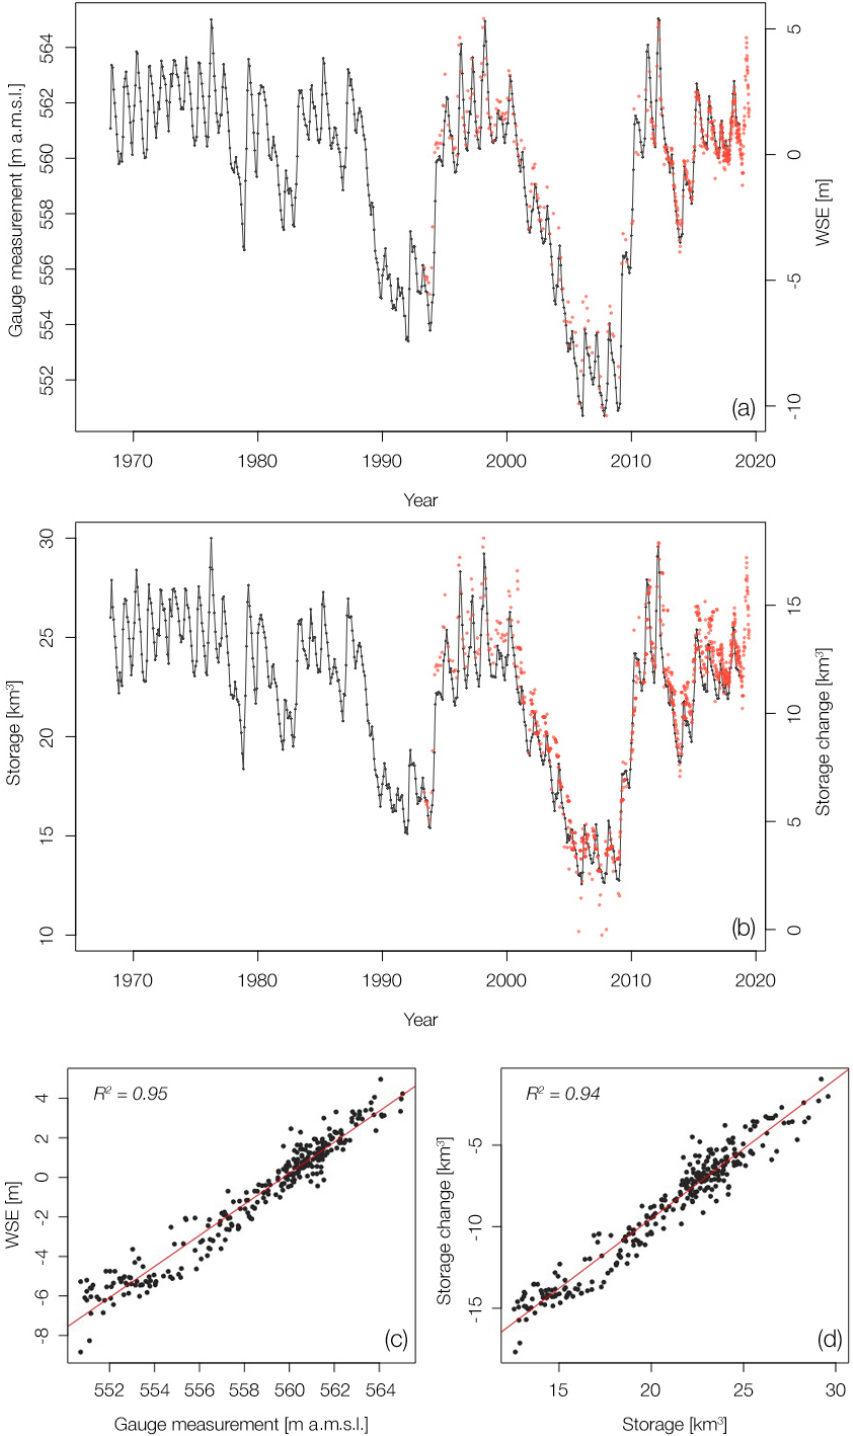
Figure 8. Water levels and storage at Lake Sakakawea. (a) In situ monthly water levels (black) versus WSE records (red); (b) in situ monthly water storage (black) versus (cid:49)V records (red); (c) linear regression of monthly average WSE records and concurrent in situ monthly water levels, with linear regression in red; (d) linear regression of monthly average (cid:49)V records and concurrent in situ monthly water storage, with linear regression in